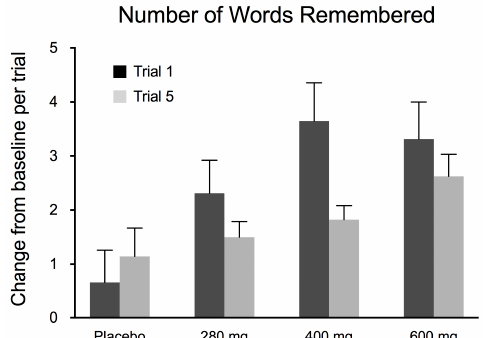
Figure 3. Changes in numbers of words remembered, before and after 3 weeks of fibroin protein enzymatic hydrolysate (FPEH), in Trials 1 (black bars) and 5 (gray bars) of the Korean version of the Rey Auditory Verbal Learning Test (KAVLT) is exhibited on the y -axis. The change in each group in the number of words remembered was assessed by ANOVA and was significant for Trials 1 ( p = 0.0126) and 5 ( p = 0.0463). Each value is the mean with the